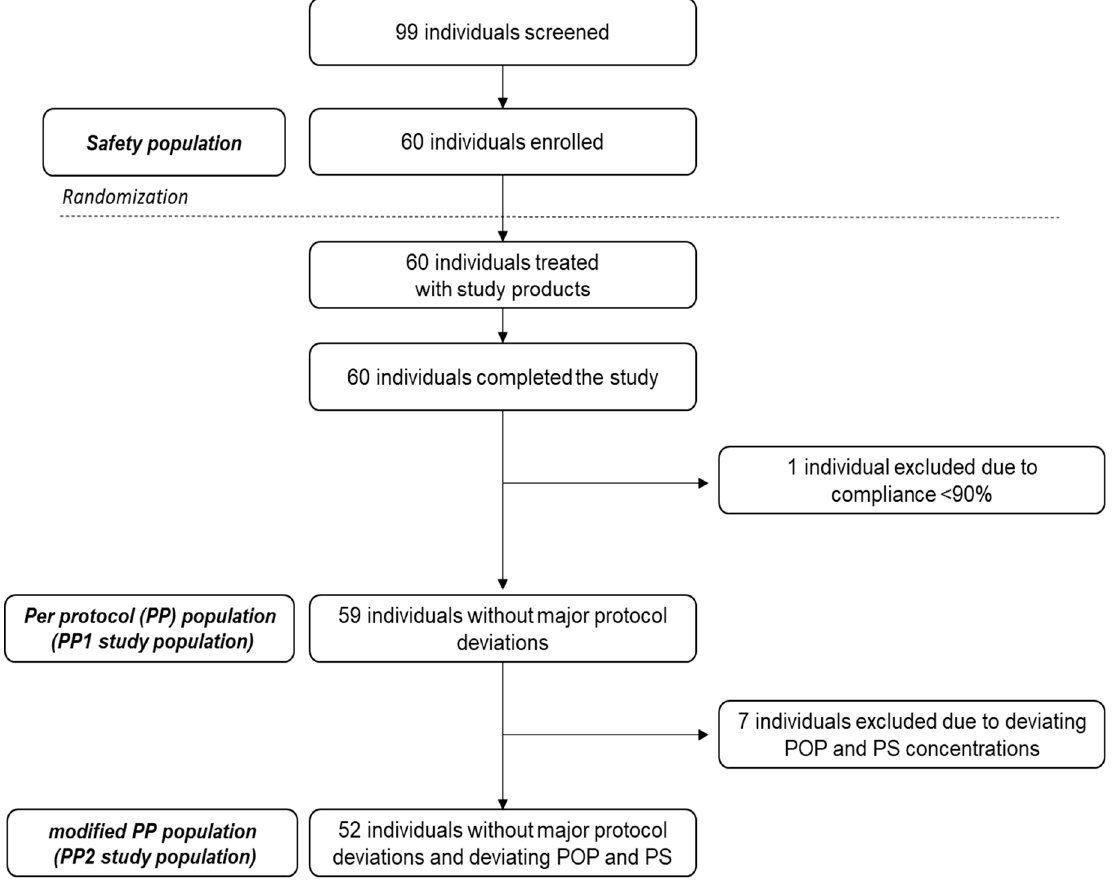
Figure 1. Flow diagram depicting the flow of participants throughout the study. POP: plant sterol oxidation products, PS: plant sterols.